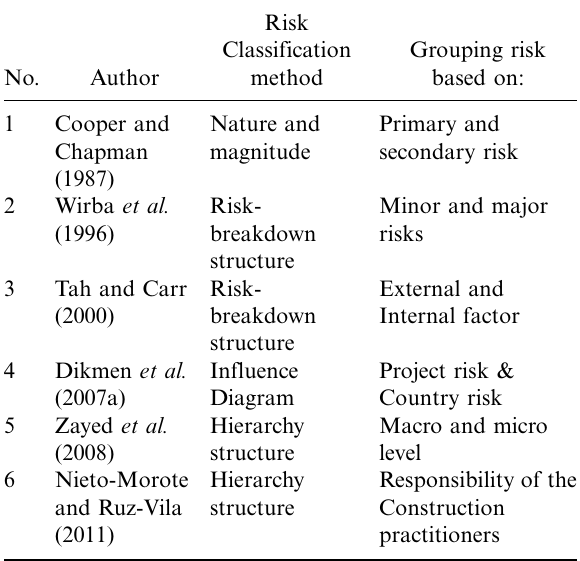
Table 2. Previous introduced risk classification methods